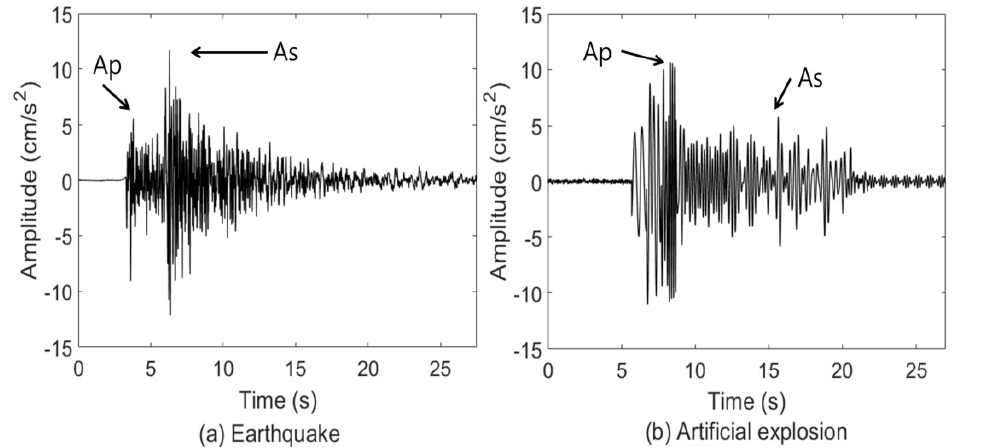
Figure 1. Peak amplitudes of P- and